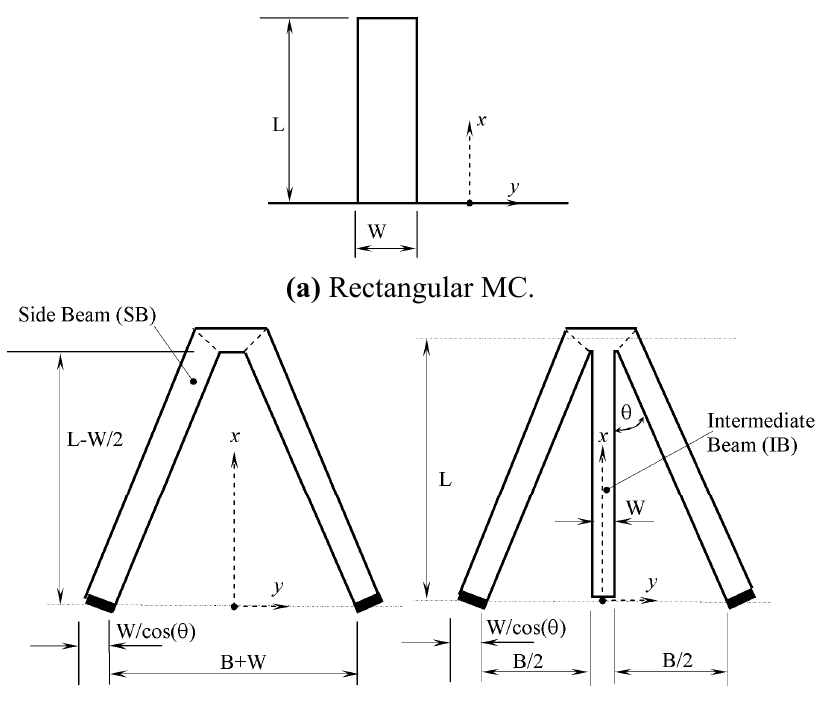
Figure 1. Schematic diagrams and the corresponding coordinate system for microcantlievers (MC) assemblies: (a) Rectangular MC; (b) the modified Triangular MC assembly; and (c) the ε -MC